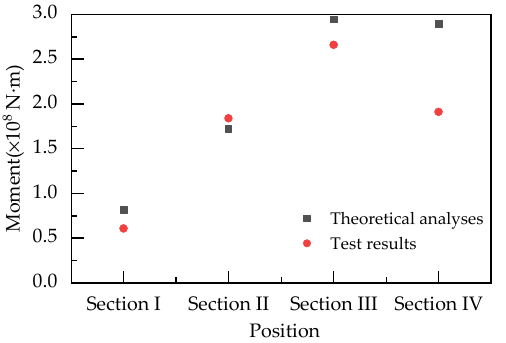
Figure 13. Comparison of bending moments of lining between the theoretical analysis and the model tests.